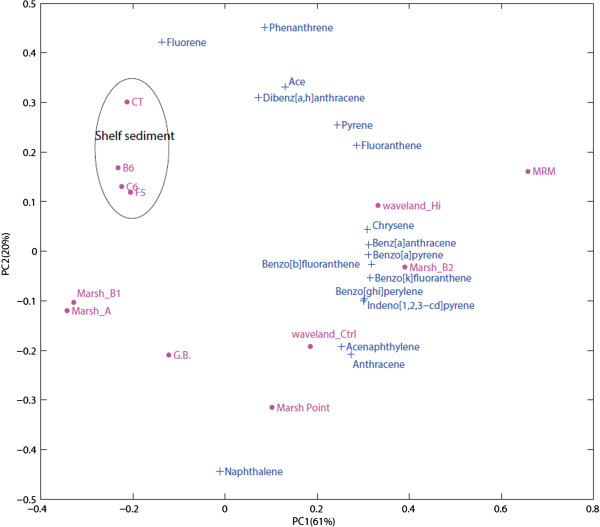
Principal component analysis (PCA) on PAH composition in sediments. PC1 explained 61% of the variance of the data matrix, and PC2 20% of the rest. Shelf sediments were clearly separated from marsh sediments.